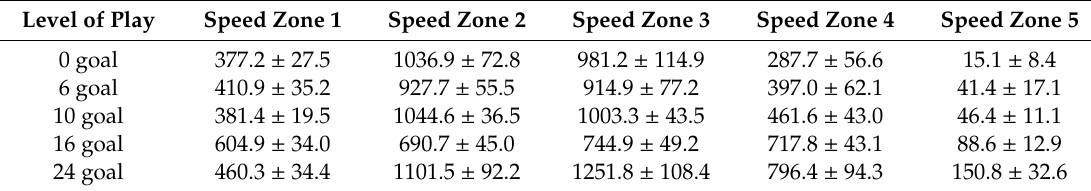
Figure 1. Box-plot of the median distance (m) per chukka at each level of play. Lower and upper box boundaries 25th and 75th percentiles, respectively, line inside box median, lower and upper error lines minimum and maximum, respectively. Table 1. Distance (m) covered in each speed zone, per chukka at each level of play. Data are presented as means ± 90% confidence intervals.